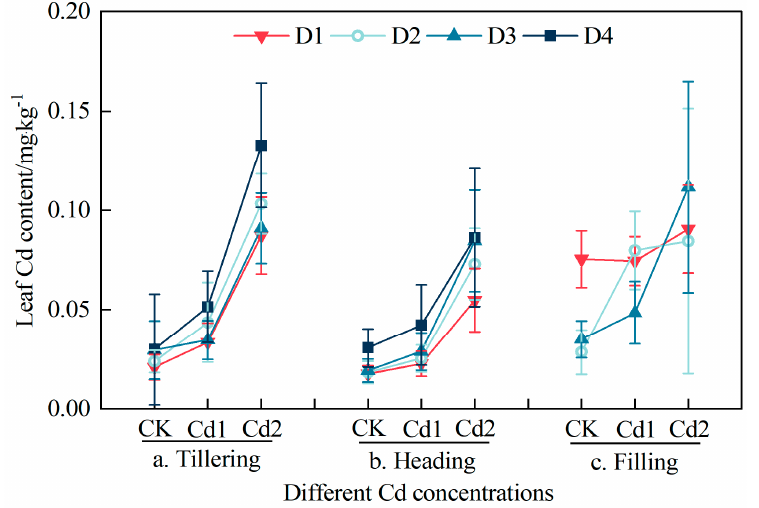
Figure 3. Effect of different Cd stress concentrations on Cd content of rice canopy leaves during different growth stages (( a ) Tillering; ( b ) Heading; ( c ) Filling). D1-D4 represent the leaf position from top to bottom of the plant.